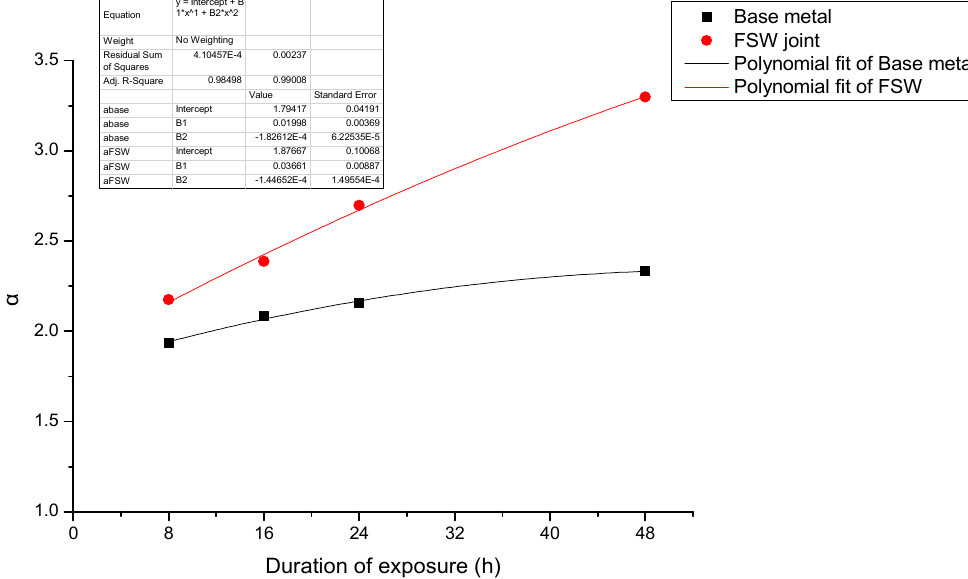
Figure 17. Variation of ratio of maximum depth to average depth with time of exposure to the chosen environment at an applied stress ( σ ) of 79 MPa.